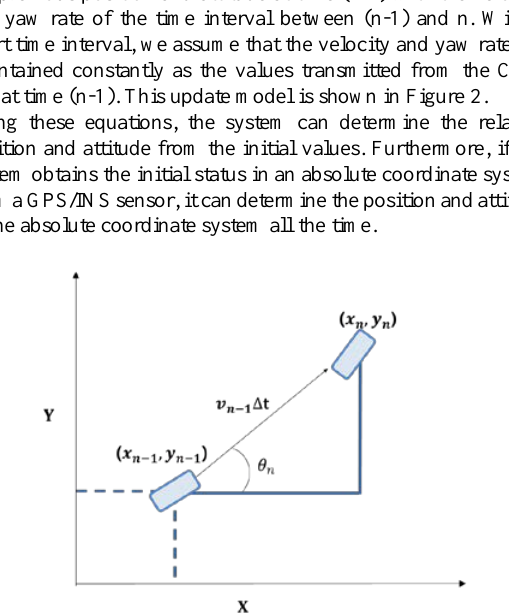
Figure 2. The position and attitude estimation model